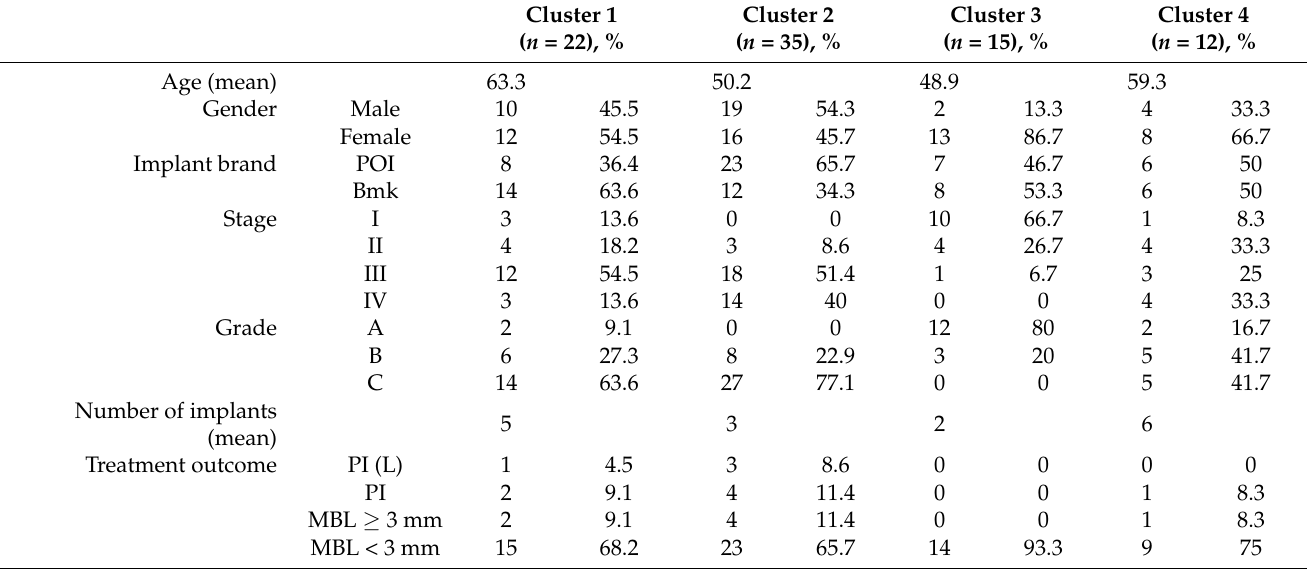
Table 4. Features among four clusters at patient